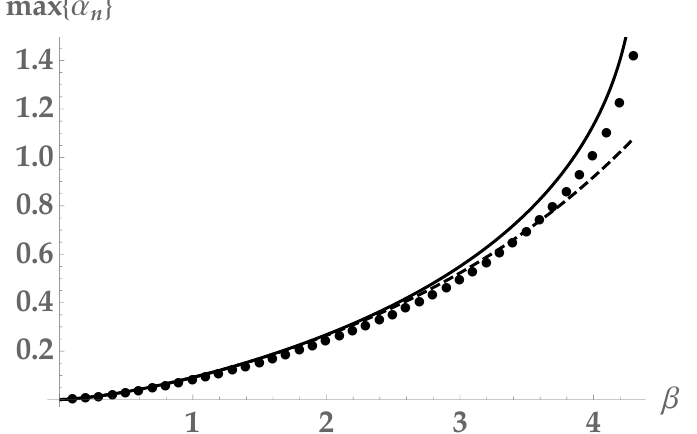
Figure 2 . Comparison between the edge of the exact eigenvalue distribution at N = 40 in the case of one harmonic in the potential term in (4.12) (solid circles) with the solution of (4.42) (solid line). We also show the high temperature approximation (4.46) in the one-harmonic case (dashed